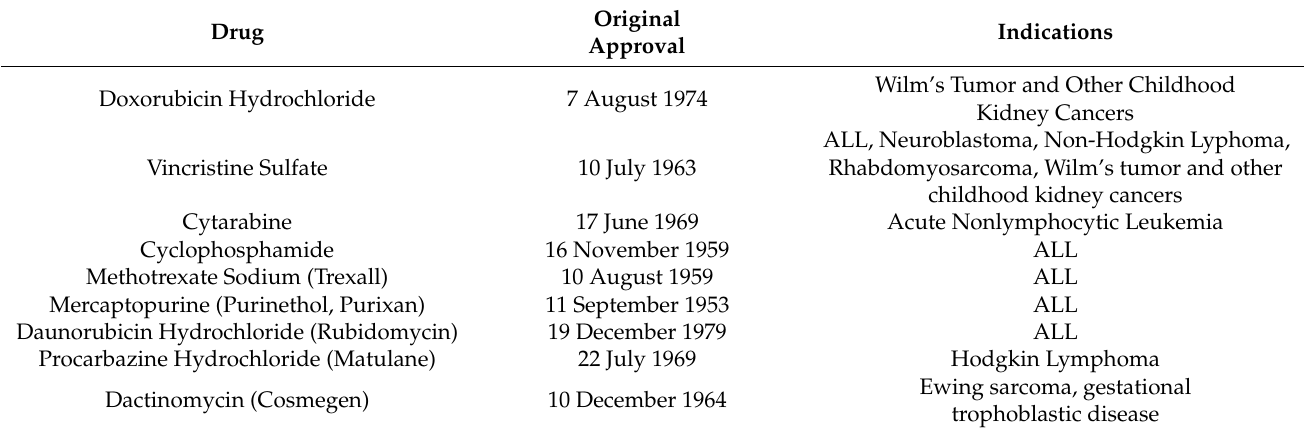
Table 1. Chemo drugs approved prior to FDAMA, for which labeling includes pediatric indications